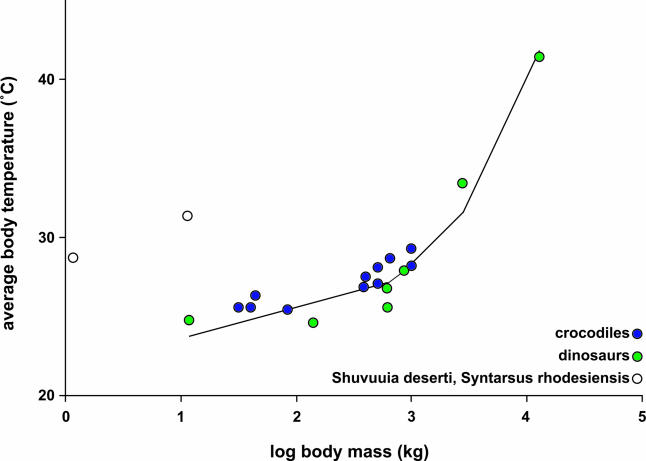
A Plot of the Relationship between Average Body Temperature (°C) and the Logarithm of Body Mass for Dinosaurs and Extant CrocodilesFor dinosaurs, body temperatures were estimated from
Equation 2 using data on ontogenetic growth trajectories determined from bone histology (see
Materials and Methods). Body mass is expressed as the size at which maximum growth rates occur, which is about half of asymptotic adult size. The fitted line includes the following species in ascending order of weight:
P. mongoliensis (12 kg),
M. carinatus (140 kg),
Al. sarcophagus (614 kg),
G. libratus (622 kg)
, D. torosus (869 kg),
T. rex (2,780 kg), and
Ap. excelsus (12,979 kg) [
8–
11]. The line was fit to the data using non-linear least squares regression in order to generate predictions on the change in body temperature with body mass for crocodiles (
Figure 2). This line does not include the two additional species shown here, the dinosaur bird
Sh. deserti (1 kg), which was not considered because it was feathered, and
Sy. rhodesiensis (11 kg), which was excluded because it was an outlier (see text). For crocodiles, body temperature estimates are based on the previously observed relative increase in body temperature with body size for individuals (32–1,010 kg) held under natural conditions, and by assuming a mean annual environmental temperature of 25 °C [
5].